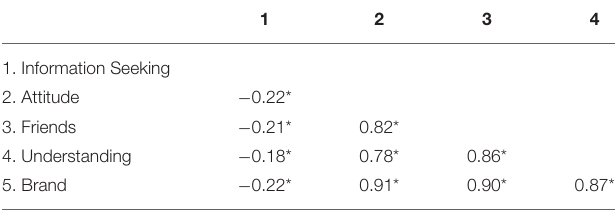
TABLE 3 | Correlation